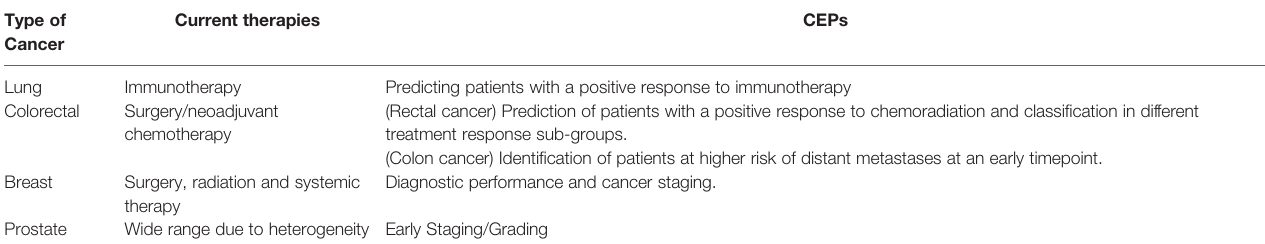
TABLE 4 | Clinical end points to be addressed in CHAIMELEON for the four targeted types of cancer. Type of